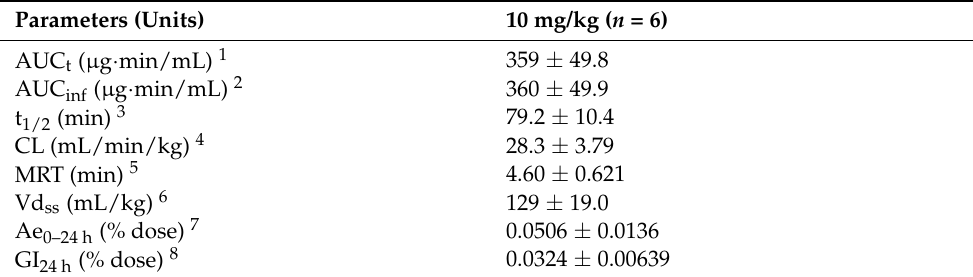
Figure 4. ( a ) Mean plasma concentration–time profiles of benzisothiazolinone (BIT) after an intra- venous injection of 10 mg/kg into rats ( n = 6); ( b ) mean concentration of BIT in various tissues at 30 min ( n = 3) and 180 min ( n = 3) after the intravenous injection. Vertical bars represent the SD. ND, not detected. Table 4. Pharmacokinetic parameters (mean ± SD) of benzisothiazolinone (BIT) after intravenous injection of 10 mg/kg BIT into rats.